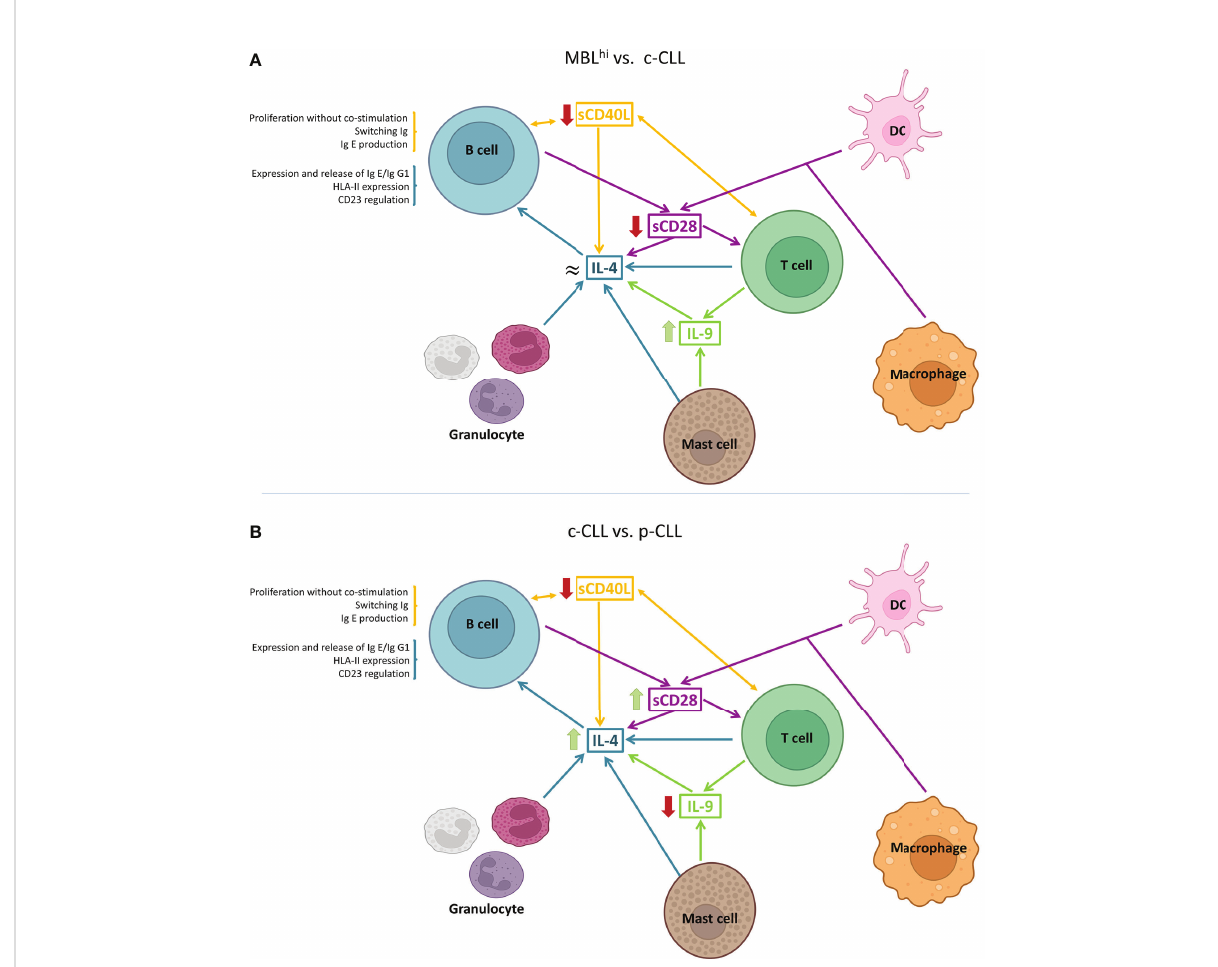
FIGURE 2 Schematic representation of IL-4-associated differential pro fi les in TME. (A) Cytokine pro fi le observed between MBLhi and c-CLL. (B) Cytokine pro fi le between c-CLL and p-CLL. (Created in